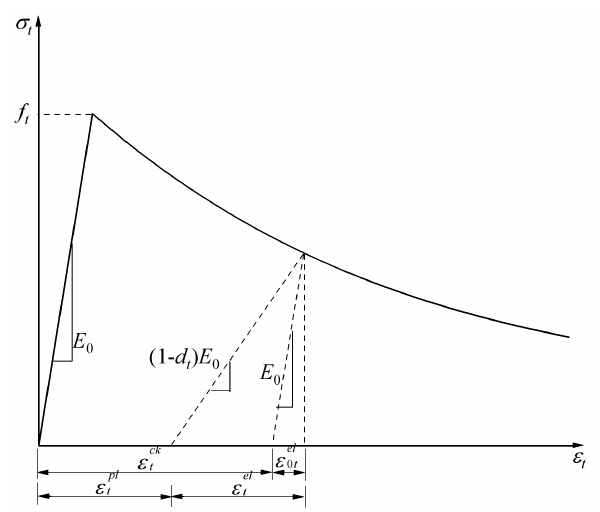
Figure 13. Response of concrete to uniaxial loading in